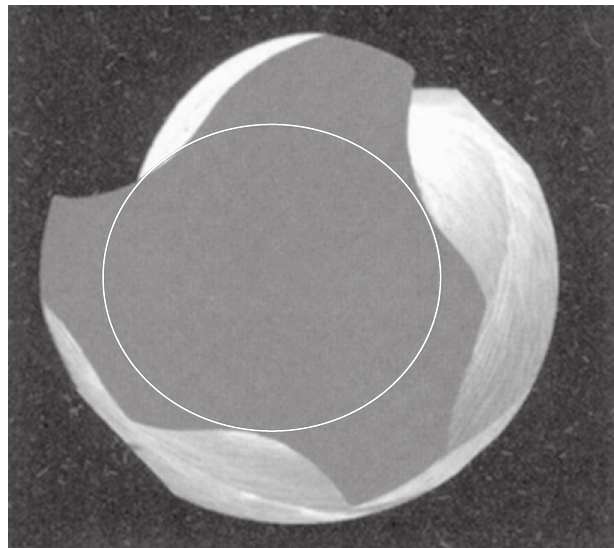
Figure 6. Representative surface fracture morphology of an endodontic file surface (K 3 Endo #15), showing the presence of microvoids with varied shapes (SEM original magnification - 2000 x